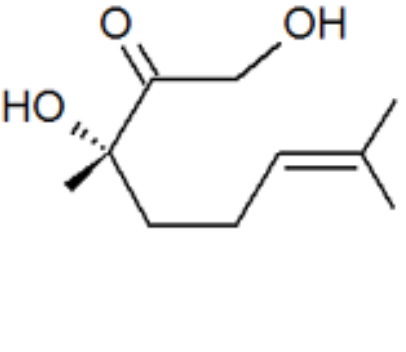
Figure 4. Male-produced aggregation pheromone for Colorado potato beetle,